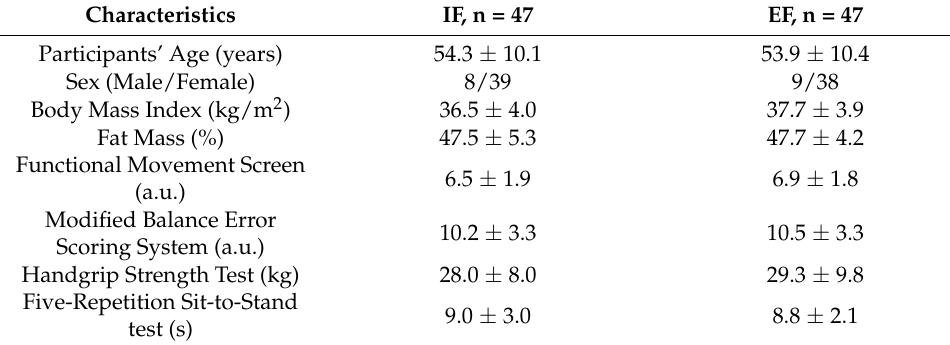
Table 2. Baseline characteristics for IF and EF